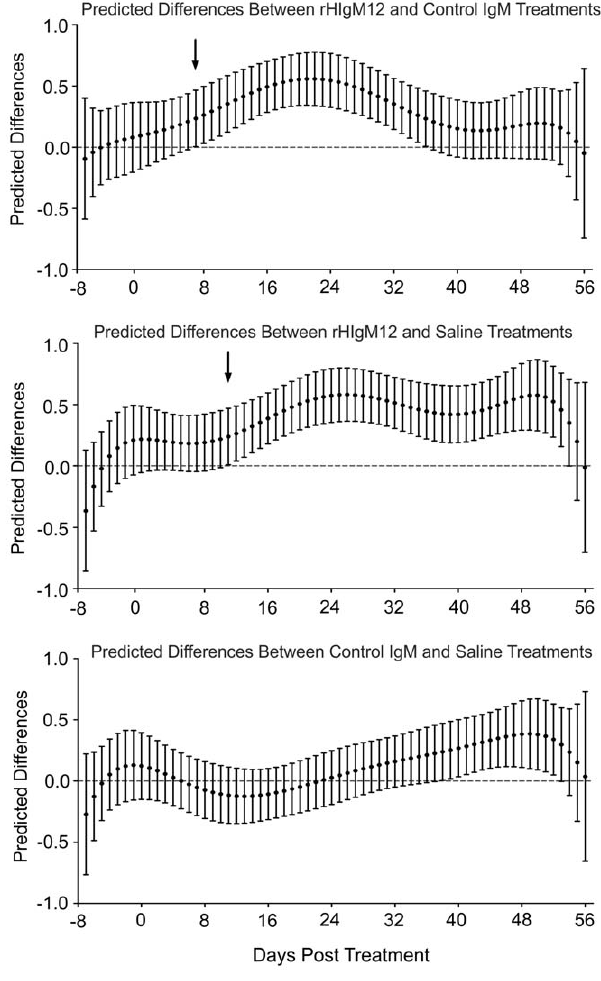
Figure 3. Comparison of three treatments at 90dpi by using predicted model values. Statistical analysis was performed for each day before and after the treatment. Horizontal nocturnal activity of rHIgM12-treated mice as compared to control IgM- and saline-treated mice significantly diverged/improved on day 7 (p=0.045) and day 11 (p=0.042) post-treatment, respectively (denoted by black arrows). The pointwise 95% confidence bands are given for each day.